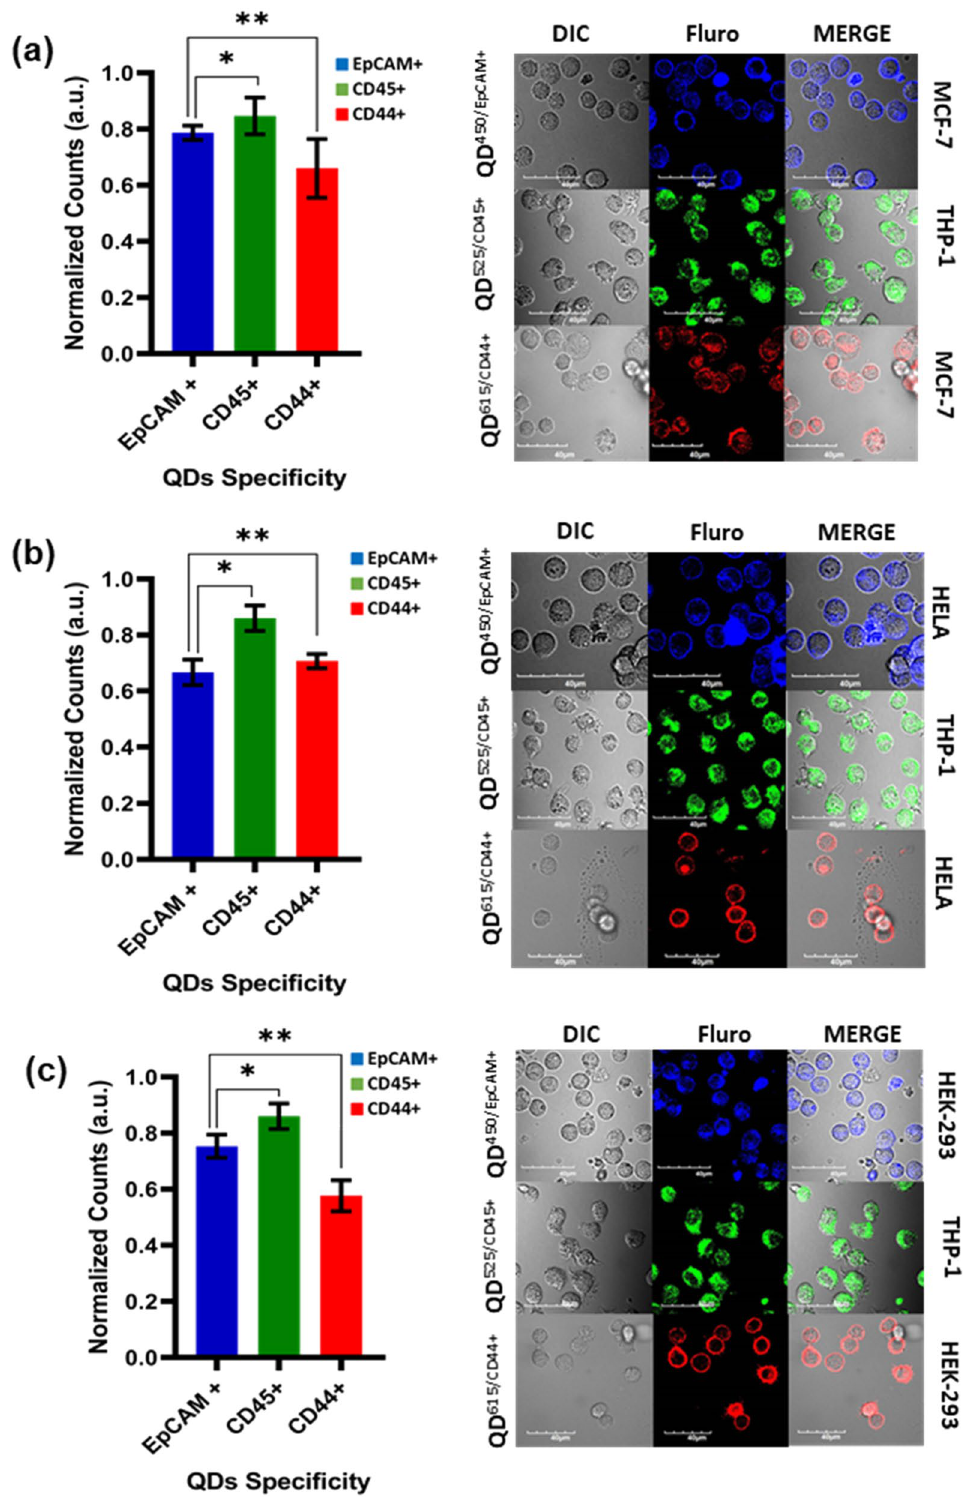
Figure 7. Multiple trails for each cell line in the co-cultures incubated with respective quantum dot antibody conjugates in-vitro with incubated with concentrations from 1.0 μg/mL media for significant analysis through Fluorescence-activated Cell Sorting and confocal imaging ( a ) MCF-7, and THP-1 ( b ) HeLa, and THP-1 ( c ) HEK-293, and THP-1 and HeLa cancer cell lines co-cultures with respective fluorescence emission shows the quantum dots binding. The statical data shows the probability of the occurrence of the EpCAM+ and EpCAM− cells, through reference through T-test was performed; “*” stands for the significance level < 0.001, and “**” stands for the significance level < 0.0001. (The data is normalized to 1.0 which is equivalent to 100%, the data should be compared based on the relative normalized to